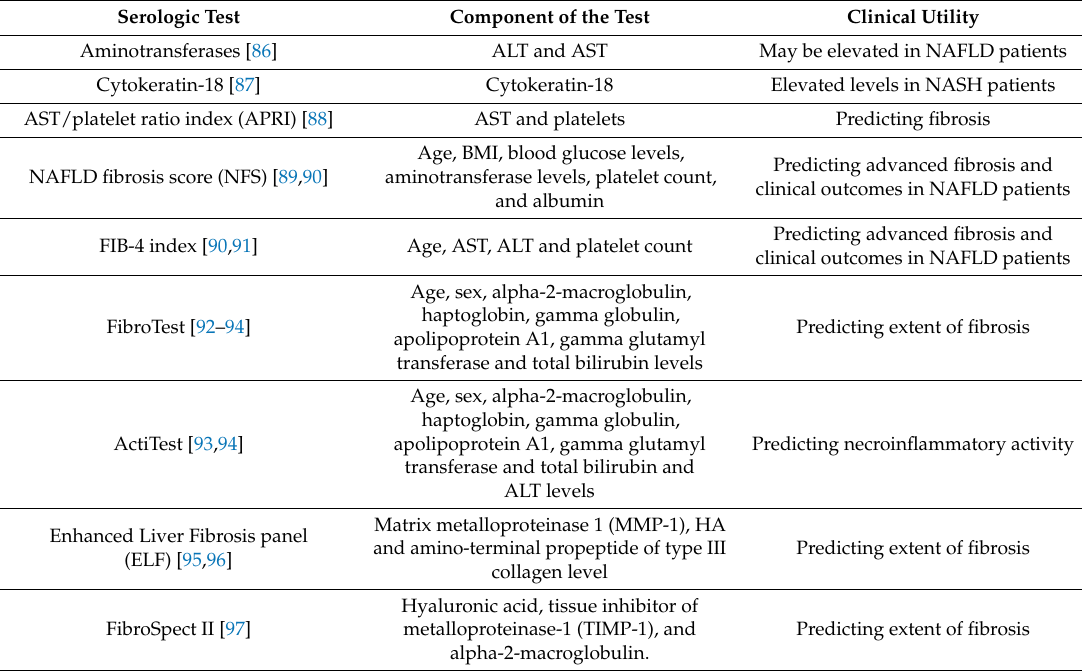
Table 6. Noninvasive serologic tests for the diagnosis of NAFLD. Serologic Test Component of the Test Clinical